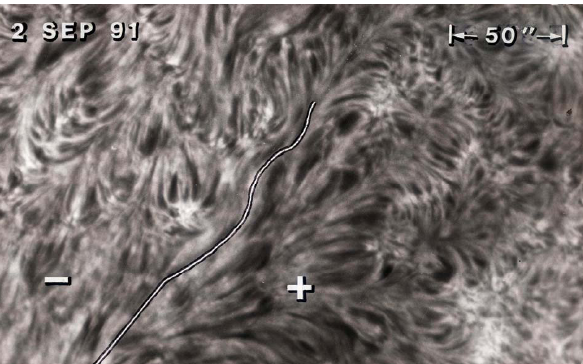
Figure 1. An empty filament channel is recognized in an H α image from the Big Bear Solar Observatory. A line is drawn along the division between the opposite polarity network fields. The fibrils are parallel with the polarity boundary and do not cross it. On each side, and relative to the plagettes, the chromospheric fibrils have an apparent root end and a more pointed end. On the positive network side, the apparent root end is in the positive polarity fields and the fibrils point toward negative magnetic fields. On the negative network side of the filament, the negative polarity is at the apparent rooted end and the fibrils point towards positive polarity fields. This pattern reveals that the magnetic fields have the same directions on the two sides of the filament channel and this allows us to deduce the sense of rotation of the field in a cross-section of the filament channel perpendicular to the polarity reversal boundary and the direction of the horizontal magnetic field component along the polarity reversal boundary.